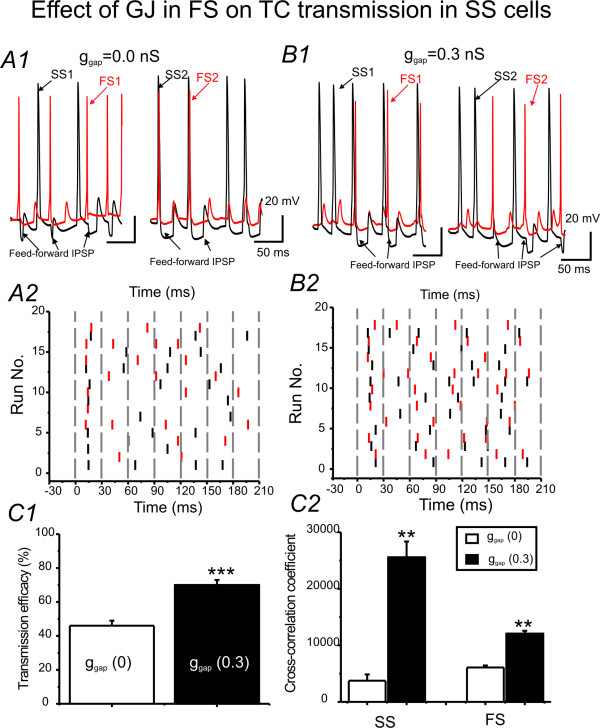
Role of EPJP in regulating TC induced spike patterns in simulated barrel circuits. A1&B1) TC (6 stimuli@30 ms interval) induced spikes in an simulated layer 4 network containing a FS pair (red trace) and a spiny stellate pair (SS, black trace). A1: EPJP = 0 nS between FS pairs. B1: EPJP = 0.3 nS between FS pairs. Note that feed-forward IPSP in spiny stellate neurons (indicated by black arrows) follows each successive spike in FS cells. A2 &B2) Raster plot of spikes induced by TC (6 stimuli @ 30 ms intervals) inputs in networks without GJ coupling (A3) and with modest GJ coupling (0.3 nS, B3). C) Spike transmission efficacy in SS cells (number of spikes/number of TC inputs (C1) and spike synchronization (C2) in barrel circuits with (filled bar, gEPJP = 0.3 nS) and without GJ coupling (open bar), ***P < 0.01; ** p < 0.01, n = 10 trials.